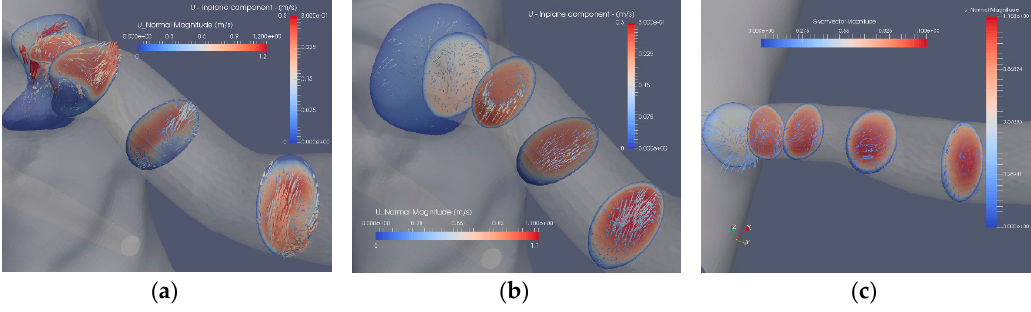
Figure 8. The axial and in-plane flow at peak flow: stenosis (Case2.1) ( a ), reconstructed (Case2.2) ( b ) and reconstructed and smoothed (Case3.3) ( c ).